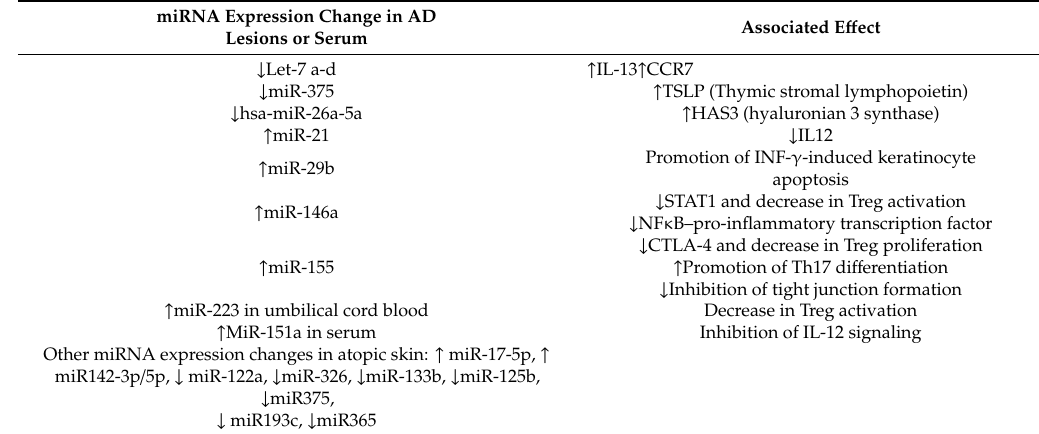
Table 3. miRNA change in atopic dermatitis (data from [7,11,53,75–78]). miRNA Expression Change in AD Lesions or